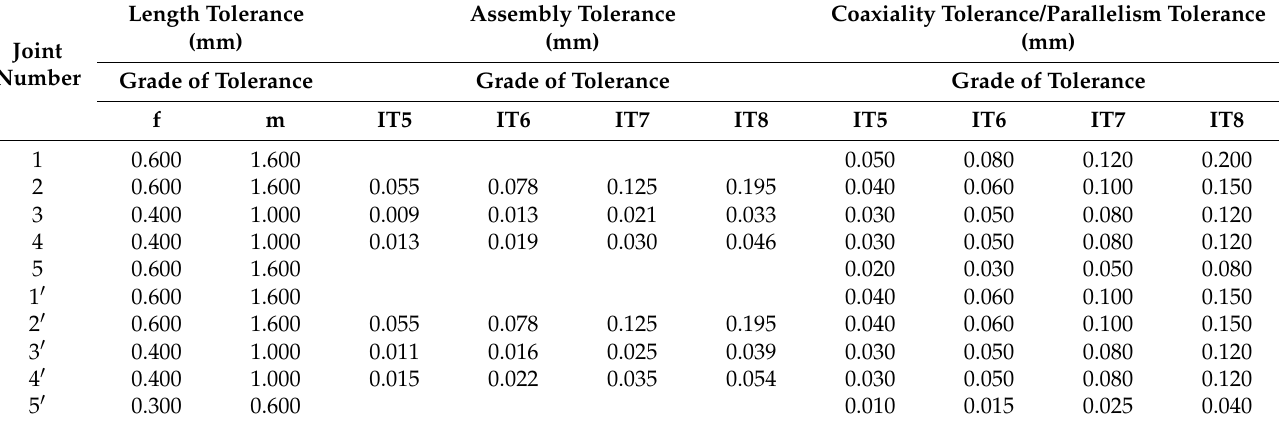
Table A1. The tolerance of structural parameters.